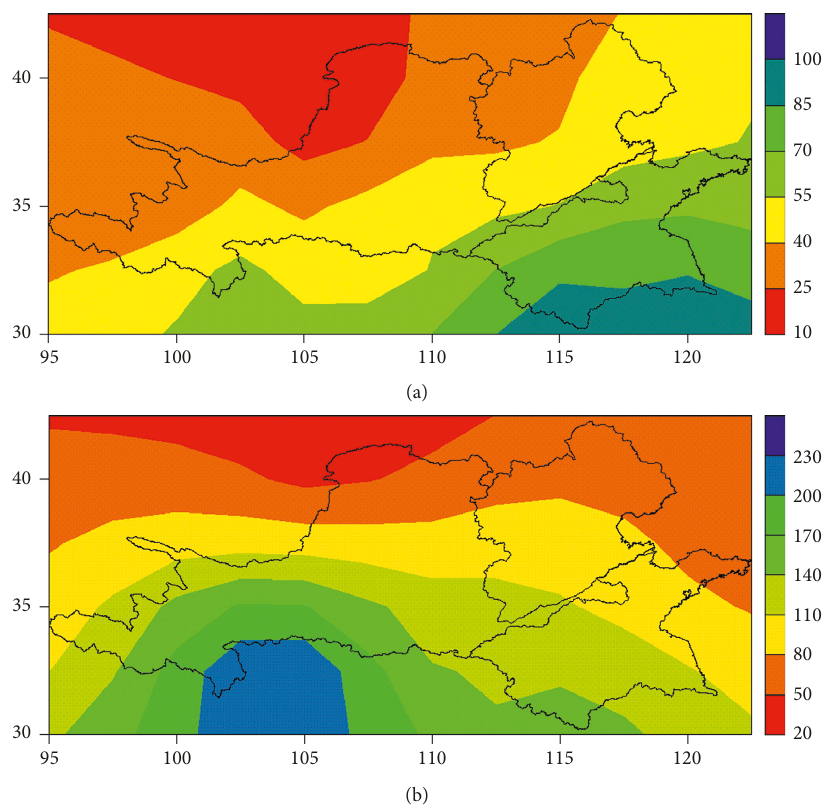
Figure 6: Spatial distribution of annual precipitation (a) observations; (b) the bnu-esm